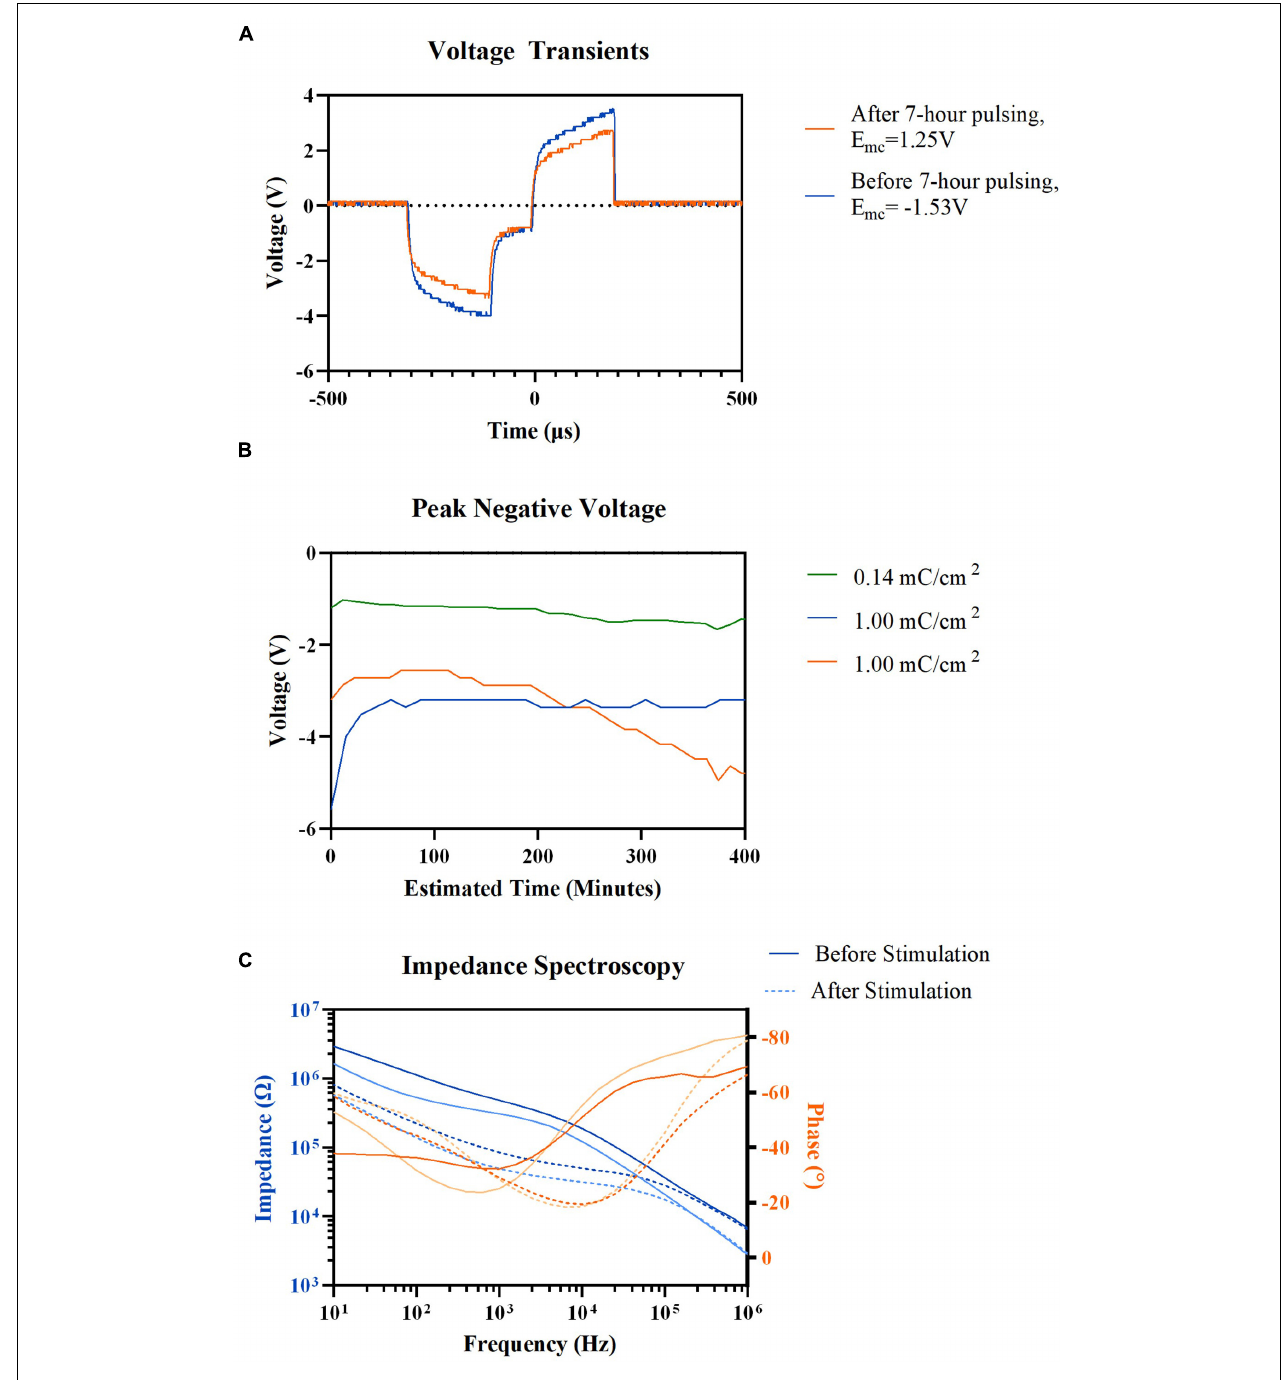
FIGURE 4 | Electrochemical properties recording result before, after, and during 7-h electric stimulation. (A) Representative voltage transient of HDCF electrode before and after 7-h electric stimulation, 1.00 mC/cm 2 current density, 72 µ A. (B) Voltage transient peak negative values measured during cathodic phase of electric stimulation in three different HDCF electrodes: (green) 0.14mC/cm 2 , (blue) 1.00mC/cm 2 , and (orange) 1.00mC/cm 2 . (C) Pre-(Solid lines) and post-stimulation (Dotted lines) electrochemical impedance spectroscopy results of two HDCF electrodes (Blue) Impedance values and (Orange) Electrode frequency values.